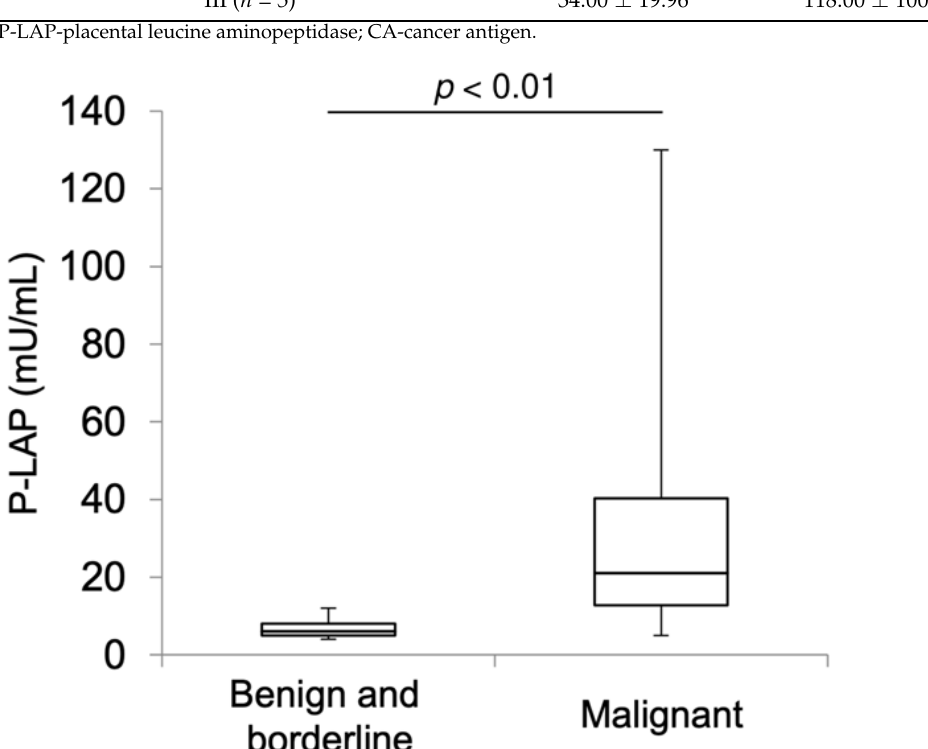
Figure 1. Box plot summary of P-LAP activity in the urine of 22 patients with benign or borderline malignant ovarian tumors and 18 patients with